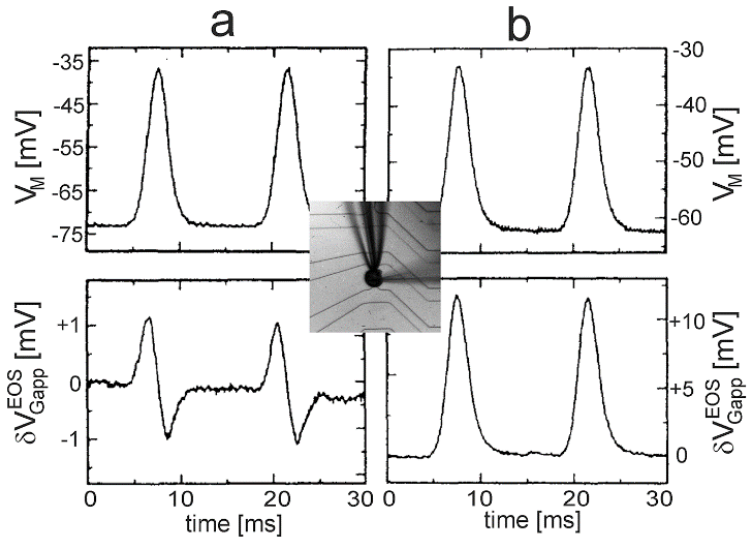
Figure 9. Transistor recording of leech neurons upon stimulation by a Gaussian transient of the intracellular voltage [39]. ( a ) Soma-substrate junction with low leak conductance. ( b ) Soma-substrate junction with an enhanced leak conductance and a reduced junction conductance. The upper graphs display the intracellular voltage V M p t q , and the lower graphs the apparent change of the gate voltage δ V EOS p t q . The micrograph shows a leech neuron on an EOSFET with a whole-cell patch-pipette used to apply the Gaussian voltage transients and with an impaled micropipette used to record the intracellular voltages.